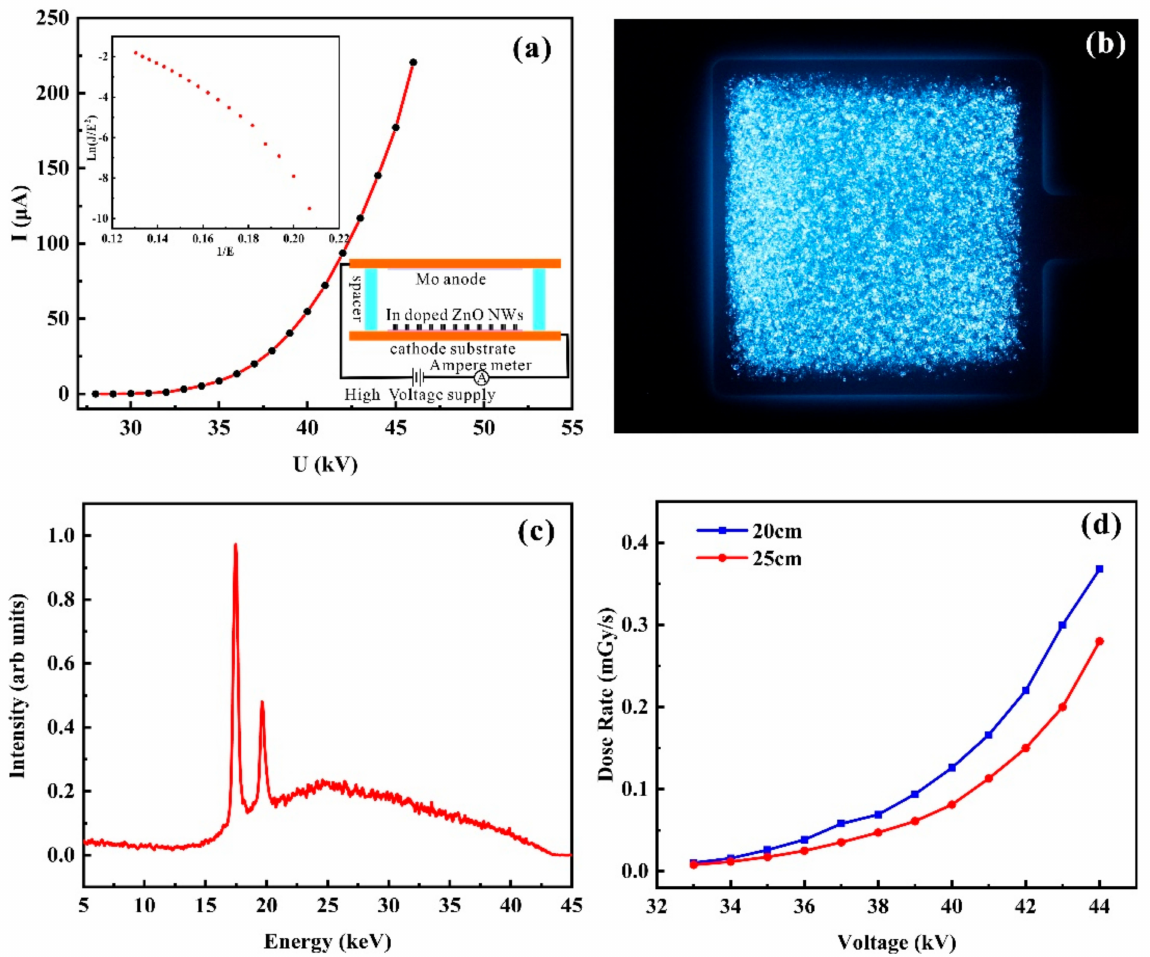
Figure 9. Characteristics of the flat-panel X-ray source. ( a ) I–V curve, (Upper Inset) F-N plot, and (Lower Inset) schematic diagram of testing device. ( b ) Visible light image recorded when the device is operated at a 46 kV anode voltage. ( c ) Nor- malized X-ray energy spectra at a 46 kV anode voltage. ( d ) X-ray dose rate vs. voltage for anode-cathode distance of 20 cm (blue squares) and 25 cm (red